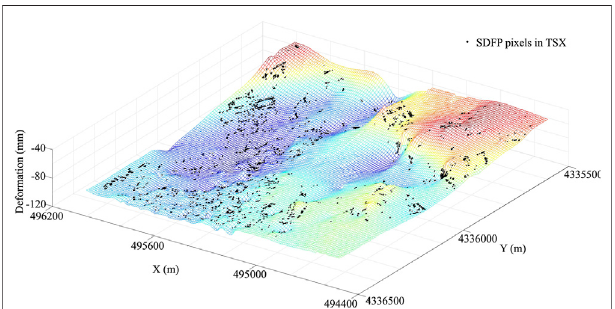
FIGURE 2 | Extracting the deformation rate of SDFP pixels in TSX by Kriging interpolation in space. The mesh grid is generated from the deformationratederivedfromASARimages.TheblackdotsdenotetheSDFP pixels selected from TSX acquisitions.